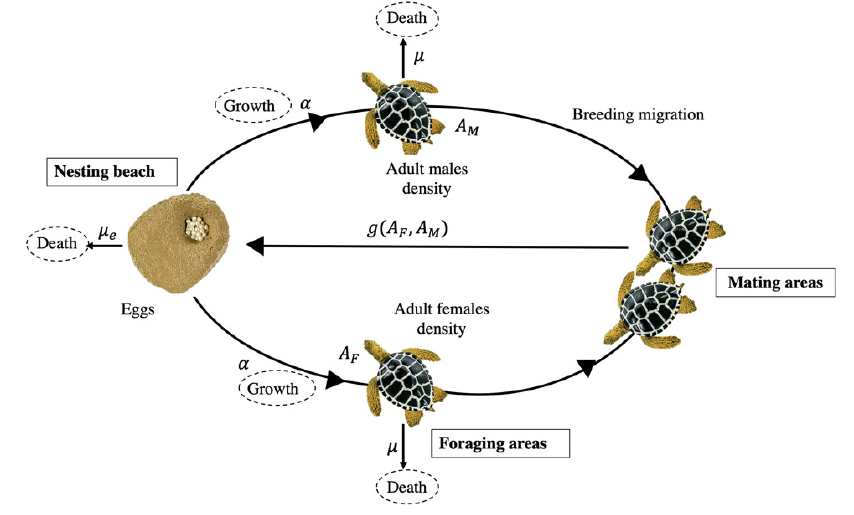
Fig. 2. Schematic diagram of the mathematical